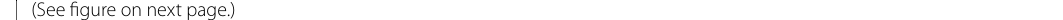
Fig. 2 Inhibition of platelet activation suppressed reactive EGCs. a , b Flow cytometric dot blots of 2-color fluorescence staining of mice platelets with anti-CD40L followed by anti-CD41-FITC. The numbers at corners indicated the percentage of CD41 and CD40L double positive population (n 4). c Serum sCD40L levels (n 6). d – f Immunofluorescence staining analysis of GFAP (green) and CD40 (red), Scale bar = = g – i Western blot analysis of GFAP and CD40 expression (n 6). The data are presented as the mean = **** P